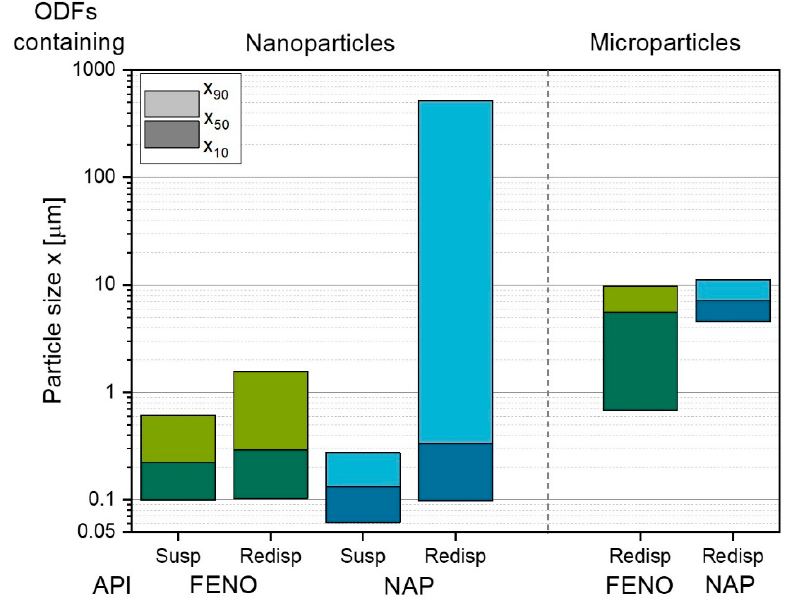
Figure 7. Particle sizes of nanosuspensions (susp) after milling of FENO and NAP and particle sizes after redispersion (redisp) of nano- and microparticle-containing